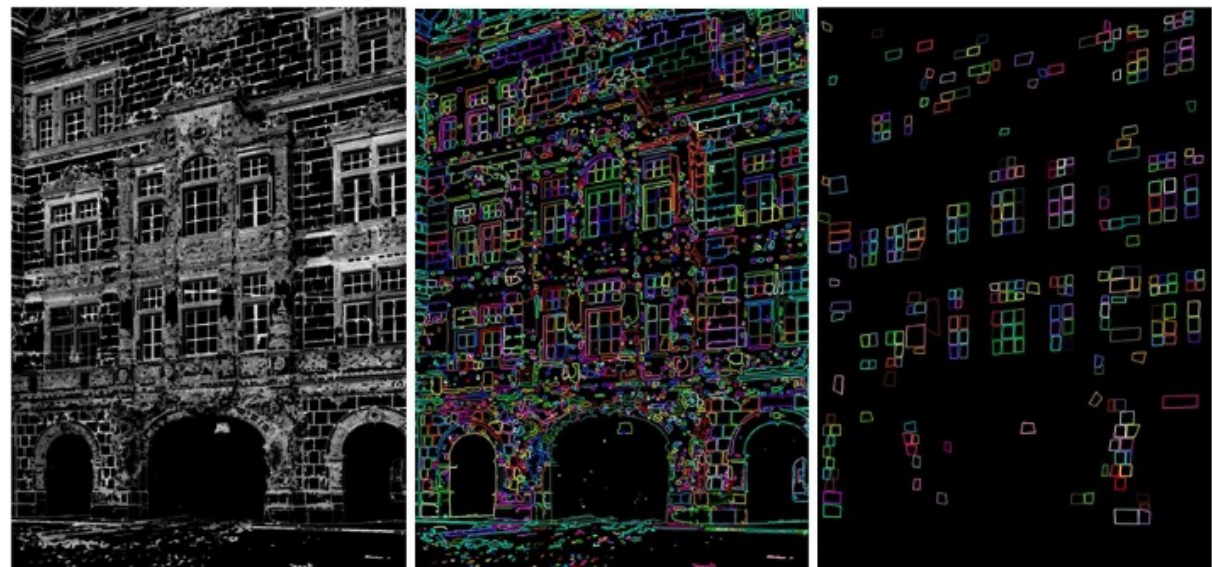
Figure 3. Canny image (left), detected closed contours using “border following” (middle) and recursive simplifying of detected contours to quadrilaterals using Douglas-Peucker algorithm